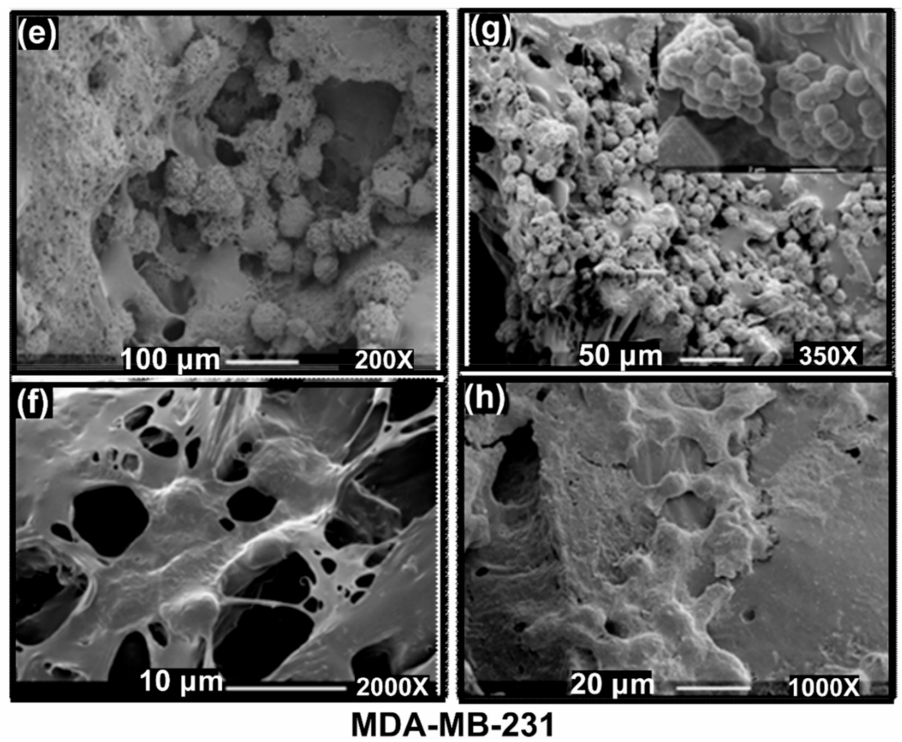
Figure 2. SEM images of cells grown on 10 mm × 10 mm × 8 mm PHA-based 3D scaffolds ( a – d ) MCF7 cells cultured on 3D PHA scaffolds at ( a , b ) Day 1 and ( c , d ) Day 5. ( b ) MDA-MB-231 cells cultured on